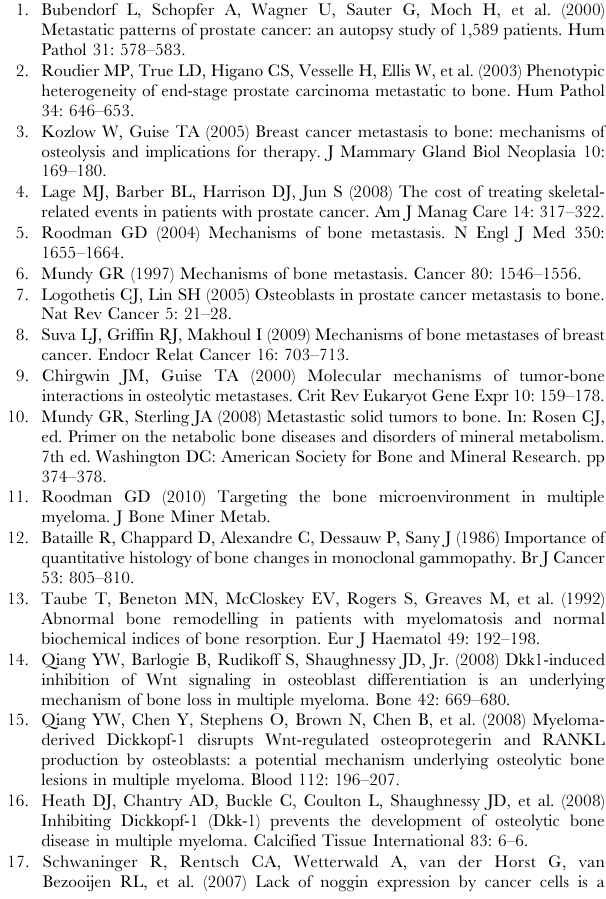
density in advanced osteolytic lesions. Radiographic aspect after intra-osseous inoculation. Figure S3 Noggin silencing promotes partial bone repair in advanced osteolytic lesions and limits late tumor growth. A . Radiographic aspect and B . 3-D reconstruc- tion ( m -CT) of tibiae xenografted with PC-3/F luc and Nog-KD clones, at day 23 (PC-3/F luc ), day 30 (Nog-KD 17) and day 33 (Nog-KD 14) after inoculation. C . Growth in vivo of PC-3/F luc and Nog-KD clones. Bioluminescent signal (photon counts + / 2 SD) emitted from the cancer cell-xenografted tibiae was quantified at day 7, 14, 21, 23, 28, 30 and 33 after intra-osseous implantation of tumor cells; n = 6–7 animals for each experimental group.